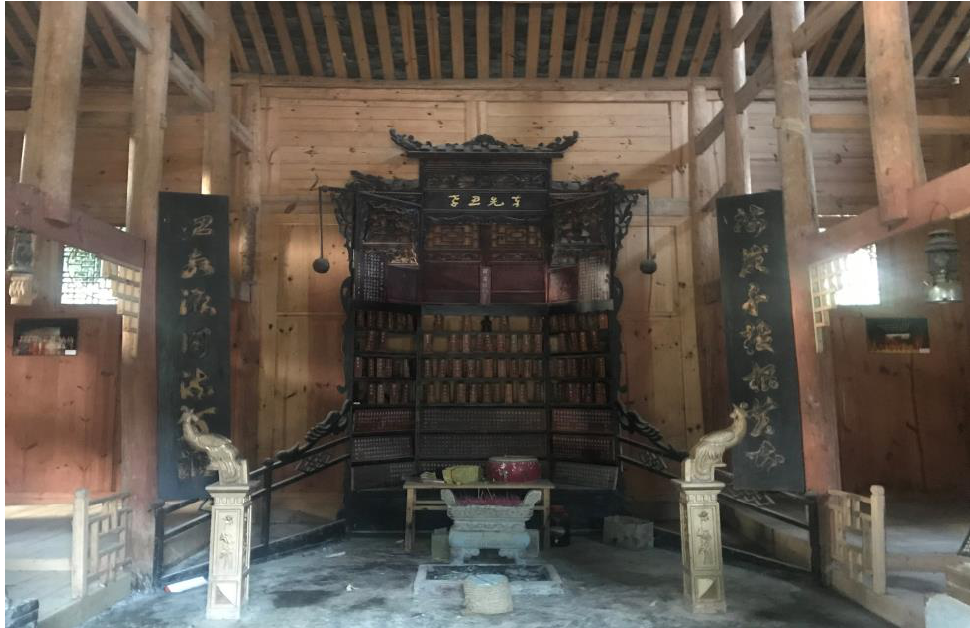
Figure 2. The village compact of LJT village, photo by Wei Wang in 2021. The second case Liuji (LJ) village is located in Rongchang County, in western Chongqing. Yin and Chen are the major clans of the village, but the village was named after Liu Ji, who was a captain of the People’s Liberation Army (PLA), to remember his sacrifice and contribution to expel bandits and save villagers’ lives. The village compact of LJT village outlines the villagers’ responsibilities to their families, neighbors, communities, society, and the